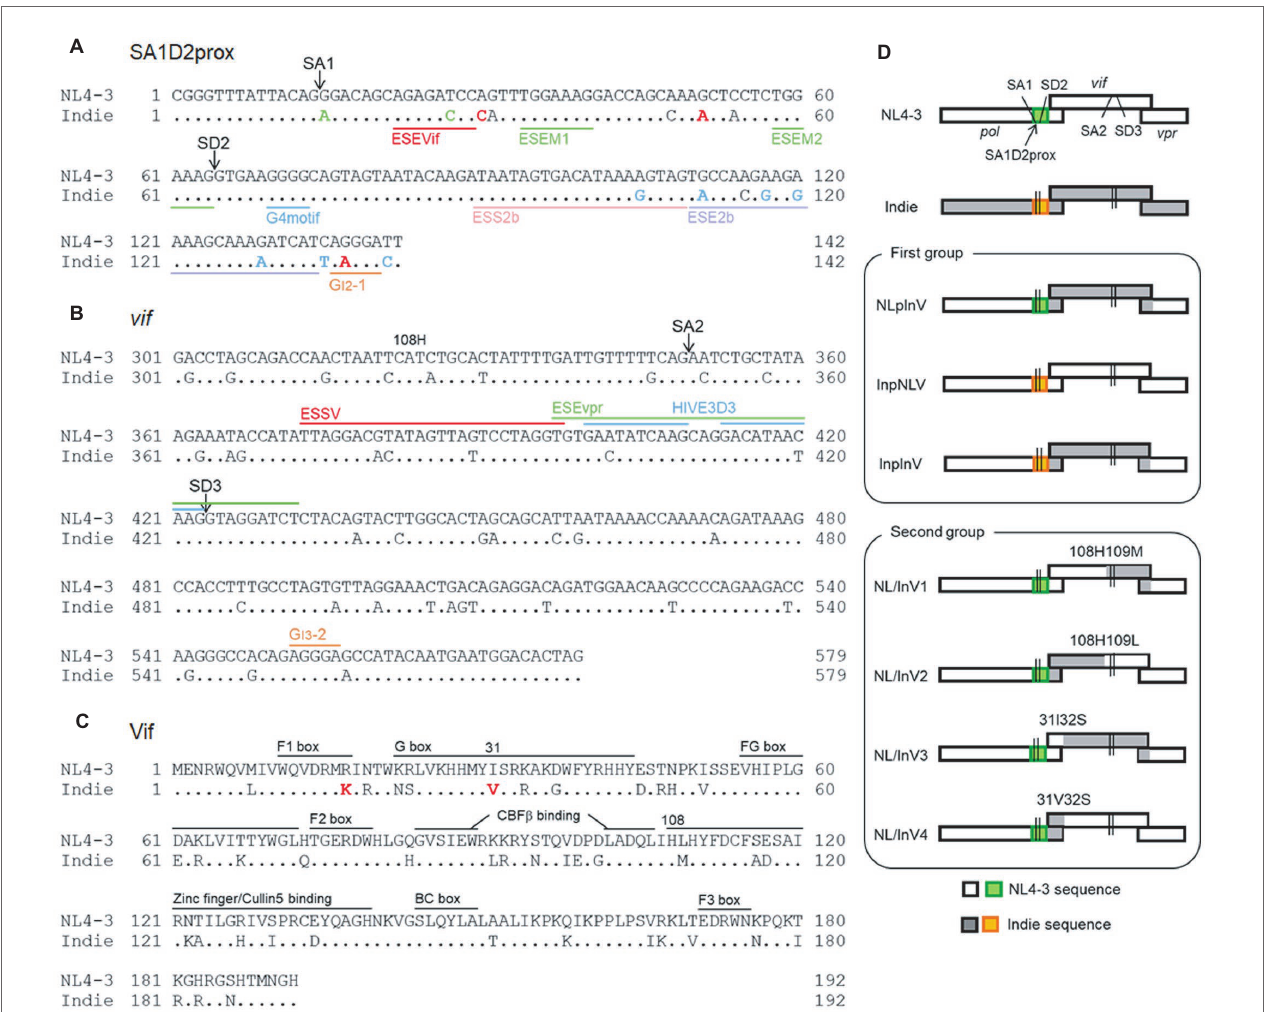
FIGURE 1 | Sequence alignment and genome organization around the vif gene of HIV-1 proviral clones used in this study. Proviral clones of HIV-1 subtype B (NL4- 3, HIV-1 NL4-3 ; GenBank: AF324493) (Adachi et al., 1986) and subtype C (Indie, HIV-1 IndieC1 ; GenBank: AB023804) (Mochizuki et al., 1999) were used in this study. Dots in the nucleotide and amino acid sequences of Indie show the nucleotides and residues identical to those of NL4-3. Sequence identities between regions of NL4-3 and Indie are as follows. (1) Nucleotide identity. SA1D2prox, 89%. Vif : nos. 1 to 324 (amino acid no. 108), 87%; no. 325 to 3 ′ end, 87%; nos. 1 to 93 (amino acid no. 31), 91%; no. 94 to 3 ′ end, 86%. (2) Amino acid identity for Vif. Nos.1 to 108, 78%; no. 109 to C-terminus, 78%; nos. 1 to 31, 80%; no. 32 to